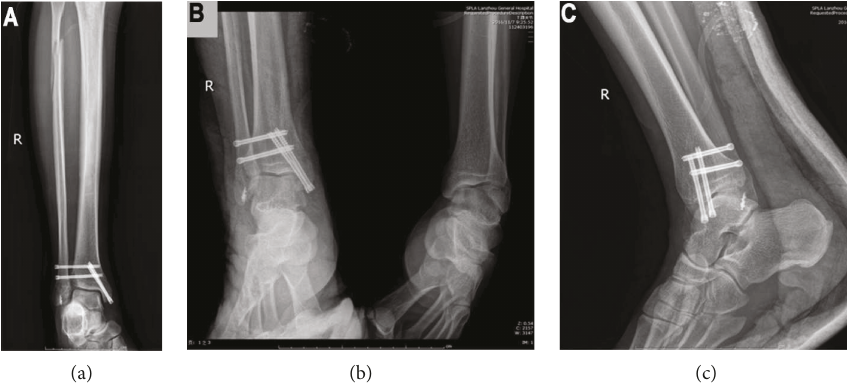
Figure 4: Posttreatment anteroposterior radiographs of the right shin and ankle and lateral radiograph of the right ankle. (a) Anteroposterior radiograph of the right shin and foot. (b) Anteroposterior radiograph of the right ankle. (c) Lateral radiograph of the right